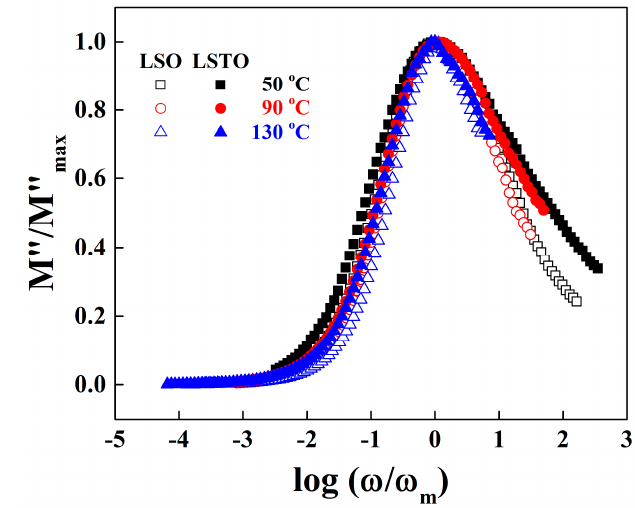
Figure 6. Normalized plot of dielectric modulus against normalized frequency for LSO (opened symbols) and LSTO (closed symbols) glasses at various temperatures.